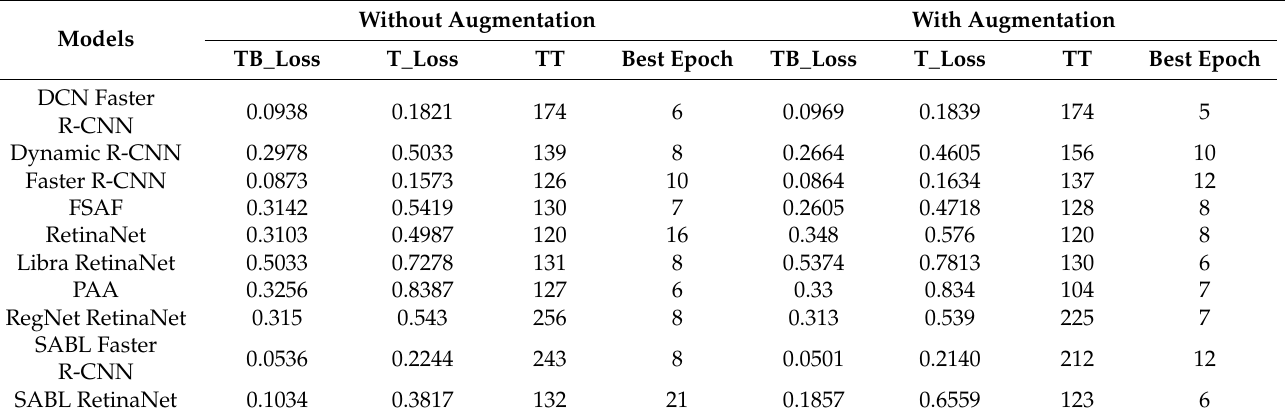
Table 5. Training loss and epoch results for the highest validation AP50 in detection